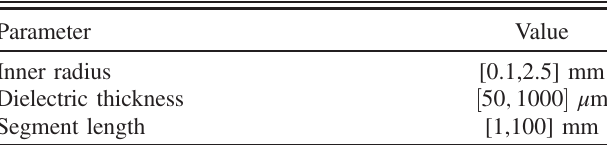
TABLE I. LPSS optimization variable ranges for each of the ten segments.